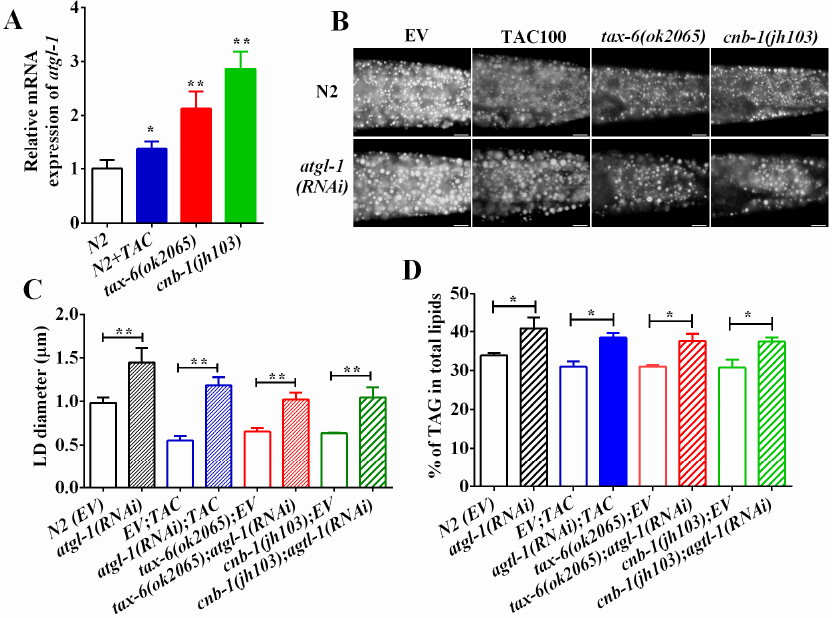
Figure 4. Calcineurin represses ATGL expression and lipolysis. ( A ) The mRNA level of atgl-1 in wild-type, tax-6(ok2065) and tacrolimus (TAC) treated worms; ( B ) Nile Red staining of fixed worms. Representative animals are shown with stained lipid droplets (LDs) in the posterior region. In all of the represented animals, the anterior is indicated on the left and the posterior is indicated on the right. Scale bar represents 10 µ m; ( C ) the average size of the lipid droplets (LD) were measured from Nile Red staining of fixed worms from ( A ). n = 10 for each worm strain; and ( D ) the percentage of triacylglycerol (TAG) in total lipids (TAG + phospholipids). Data are presented as the means ± SD of at least three biological repeats. * indicates significant difference between two indicated worm strains, * p < 0.05, ** p < 0.01.